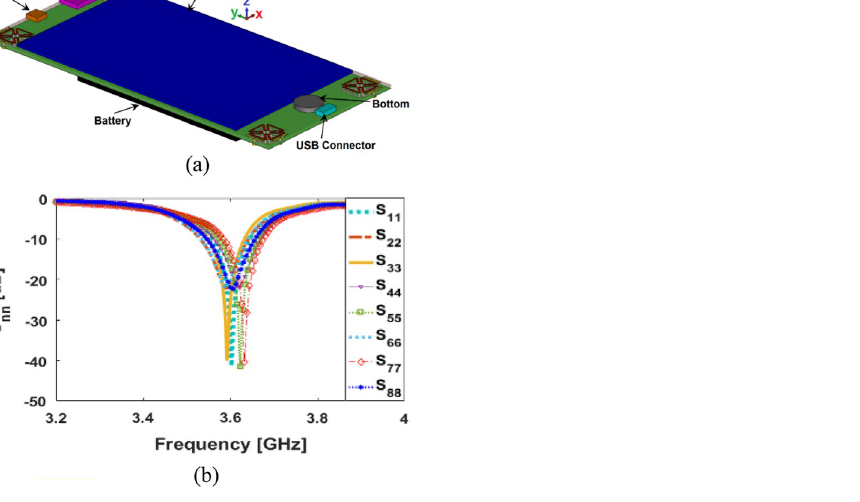
Figure 20. ( a ) Configuration and ( b ) reflection coefficients of the antenna module integrated with the